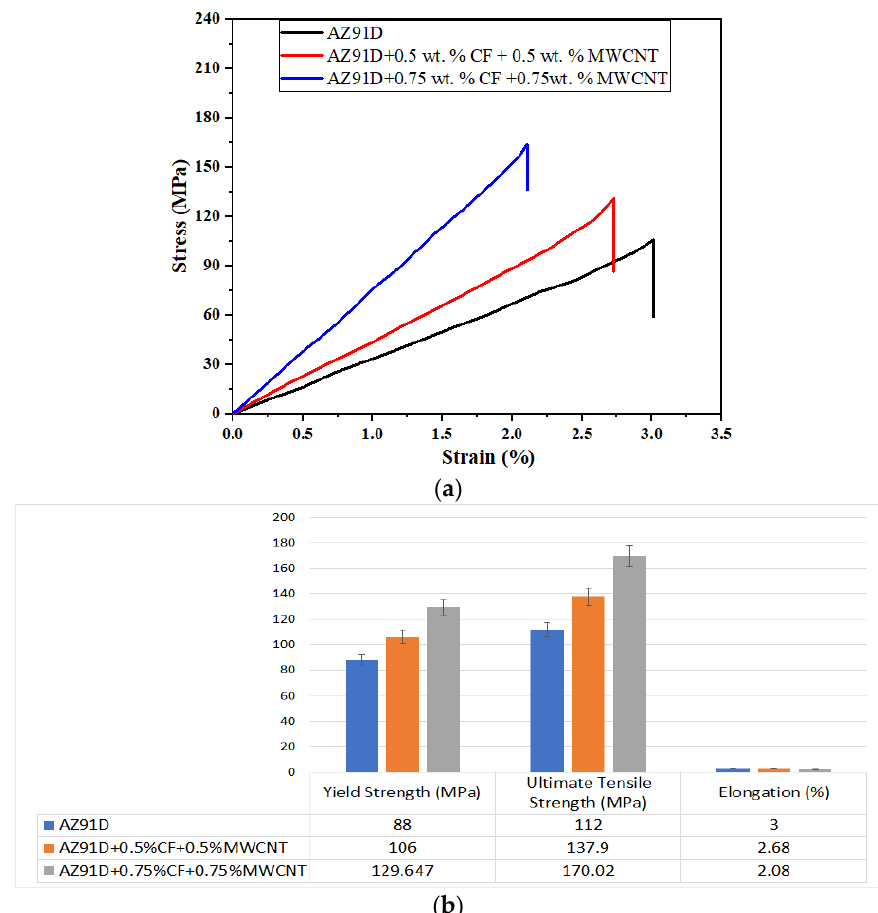
Figure 5. ( a ) Variation of yield strength, ultimate tensile strength, and elongation of Mg AZ91D hybrid composite with varying weight percentages of CF and MWCNT reinforcements; ( b ) stress–strain curves of all composites.